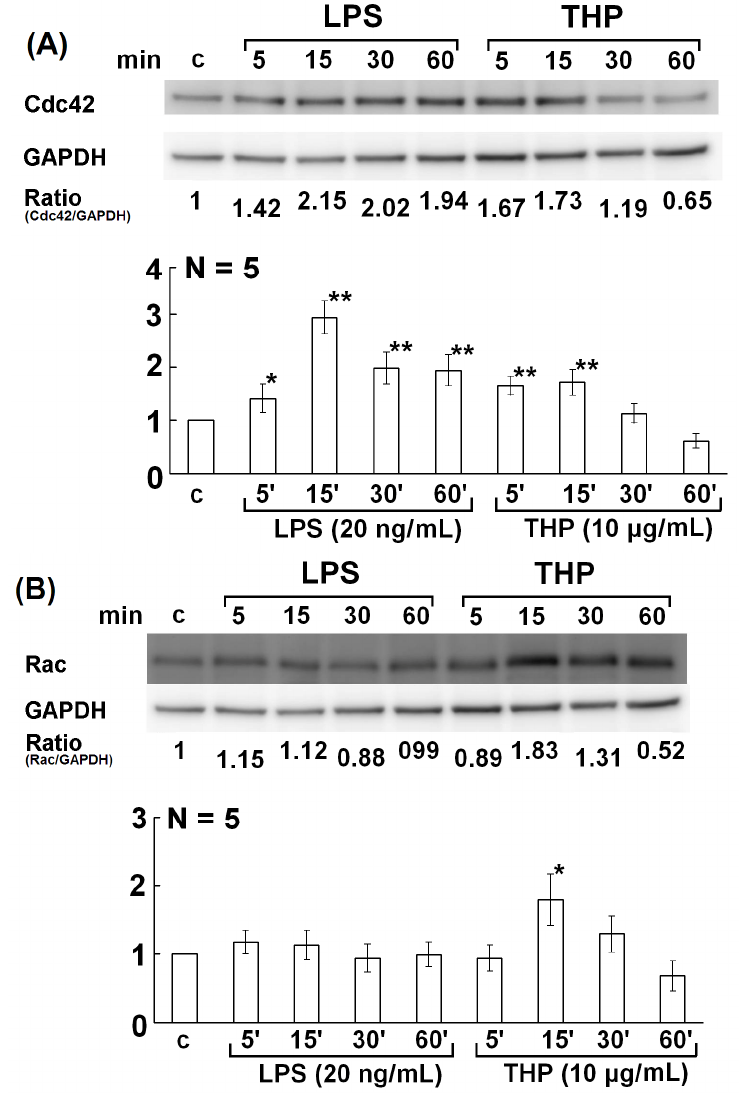
Figure 5. Kinetic expression of the Rho family small GTPase molecules Cdc42, Rac, and RhoA in HL-60 cells after stimulation with LPS (20 ng/mL) or THP (10 μ g/mL) for 5–60 min and then detected by western blot. In panels ( A – C ), the upper panel is a representative case and the lower panel shows the statistical assessment. ( A ) Cdc42, (B) Rac, and ( C ) RhoA. * denotes p ≤ 0.05 and ** denotes p ≤ 0.01 compared to